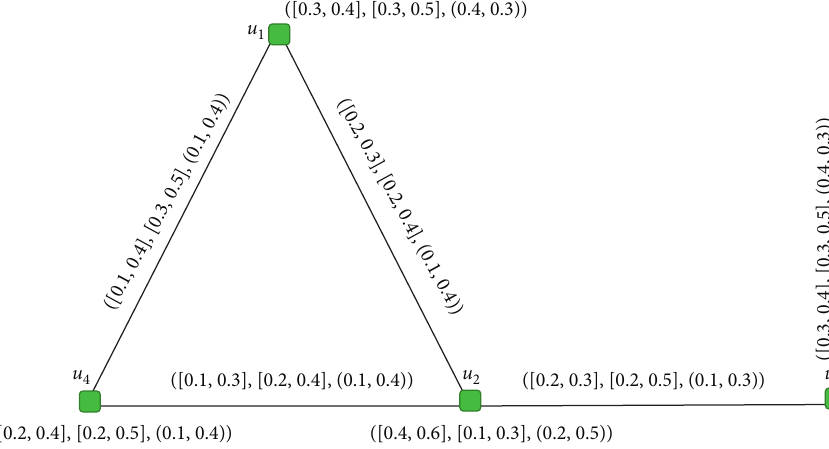
Figure 8: Cubic intuitionistic fuzzy graph.